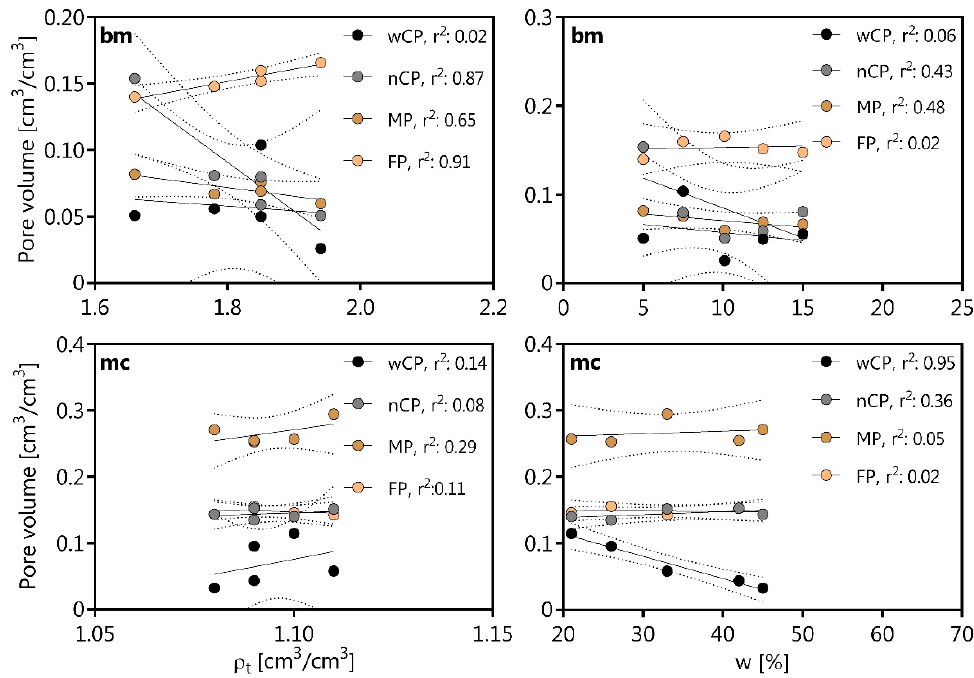
Figure 3. Linear regression of the pore volume fractions per size class for boulder marl (bm) and marsh clay (mc) with the dry bulk density ( ρ t ) and the gravimetric water content (w) during the Proctor test. The pore sizes are classified as follows: wCP = wide coarse pores (>50 µ m; > − 60 hPa), nCP = narrow coarse pores (50–10 µ m; − 60 to − 300 hPa), MP = medium pores (<10–2 µ m; − 300 to − 15,000 hPa), FP = fine pores (<2 µ m; < − 15,000 hPa). The r 2 indicates the coefficient of determination. The dashed lines indicate the confidence limits for a confidence level of 95%.